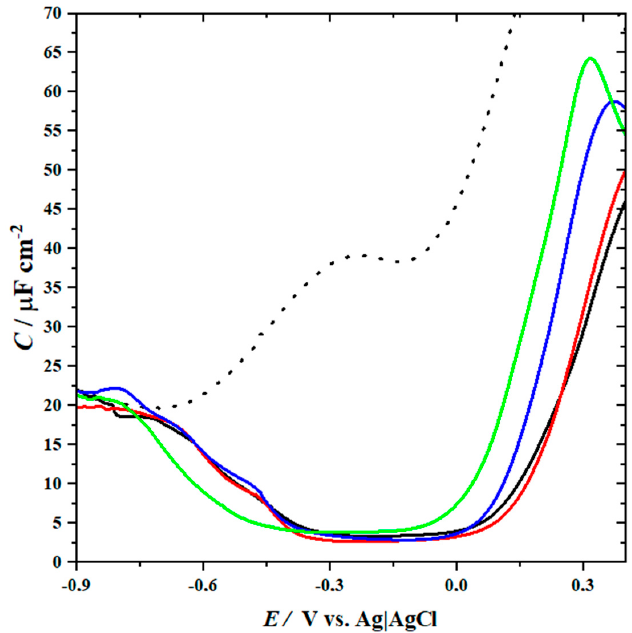
Figure 6. AC voltammetry measurements of the Au (111) electrode with the